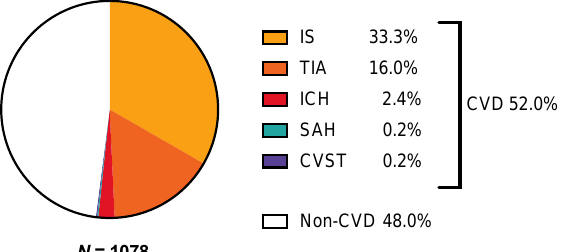
N = 1078 Figure 2. Final CVD diagnoses. Abbreviations: CVD, cerebrovascular disease; CVST, cerebral venous sinus thrombosis; ICH, intracerebral hemorrhage; IS, ischemic stroke; SAH, subarachnoid hemorrhage; TIA, transient ischemic attack.